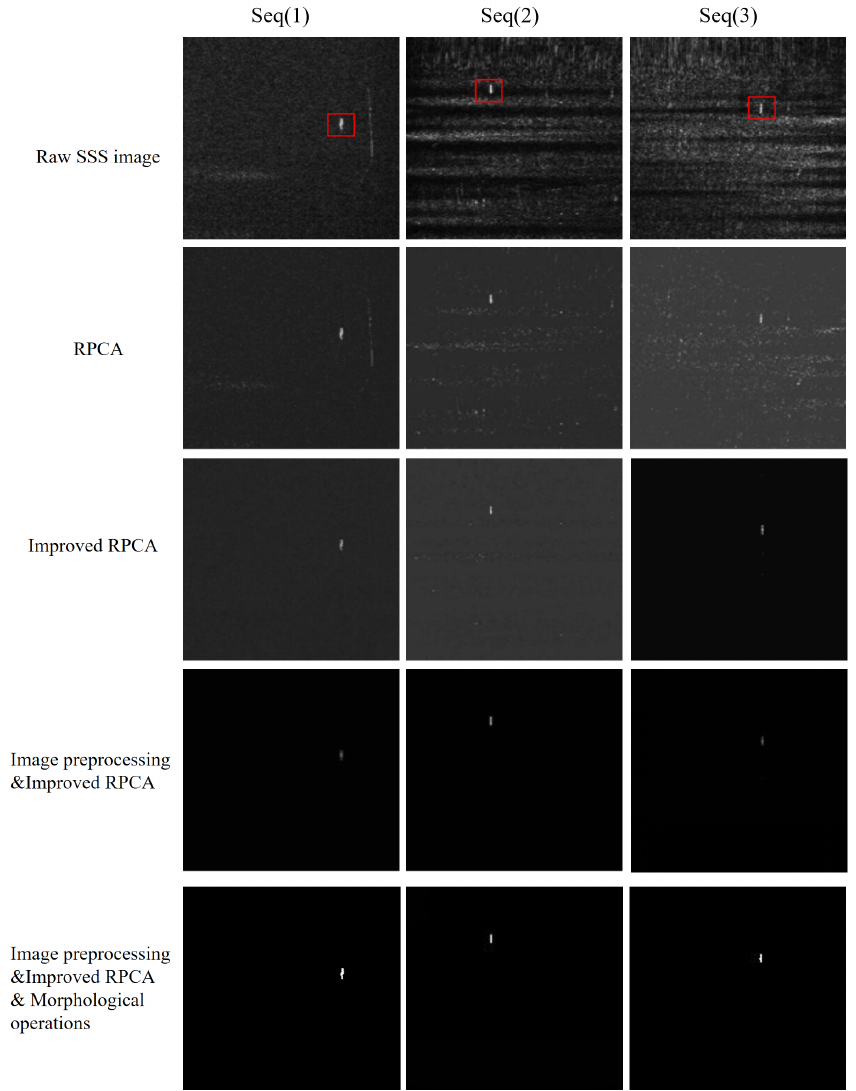
Figure 14. Visualization results of the ablation experiment. The red rectangular box is the ground